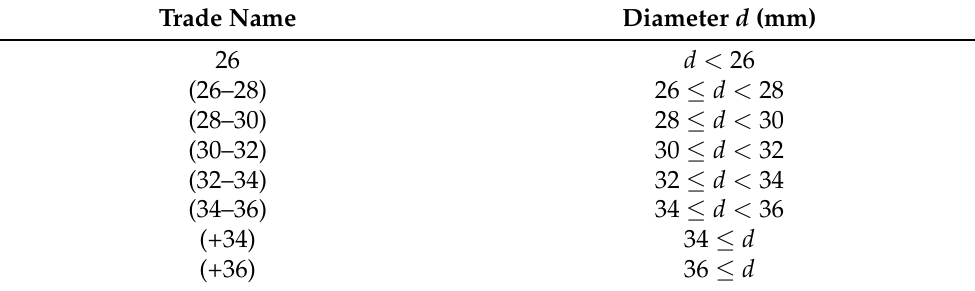
Table 2. Main size categories for in-shell walnuts. The size refers to the equatorial diameter, as mea- sured with a specialized